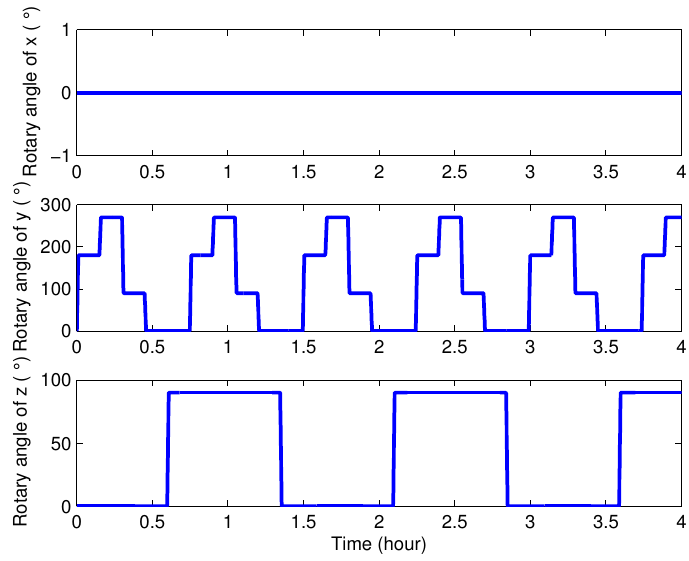
Figure 4. The rotary angle model of the proposed rotary scheme, which was rotating about the y axis and z axis.